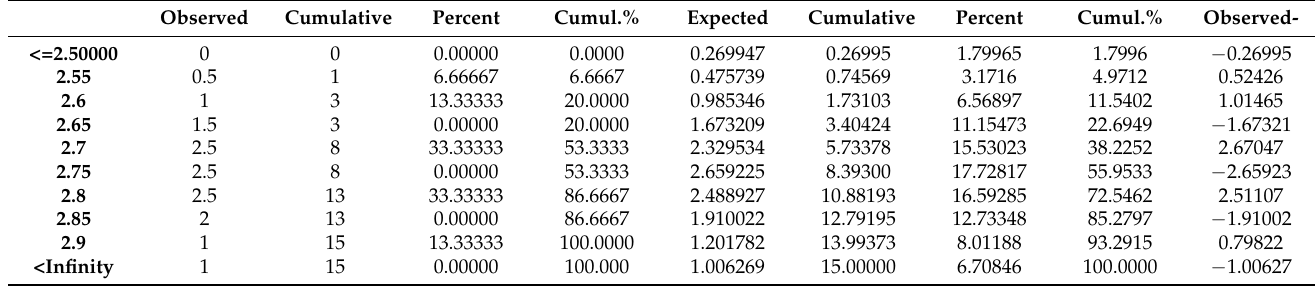
Figure 18. Histogram of experimental data sample values. Table 1. Calculation of statistics criterion—distribution of a random variable over intervals.